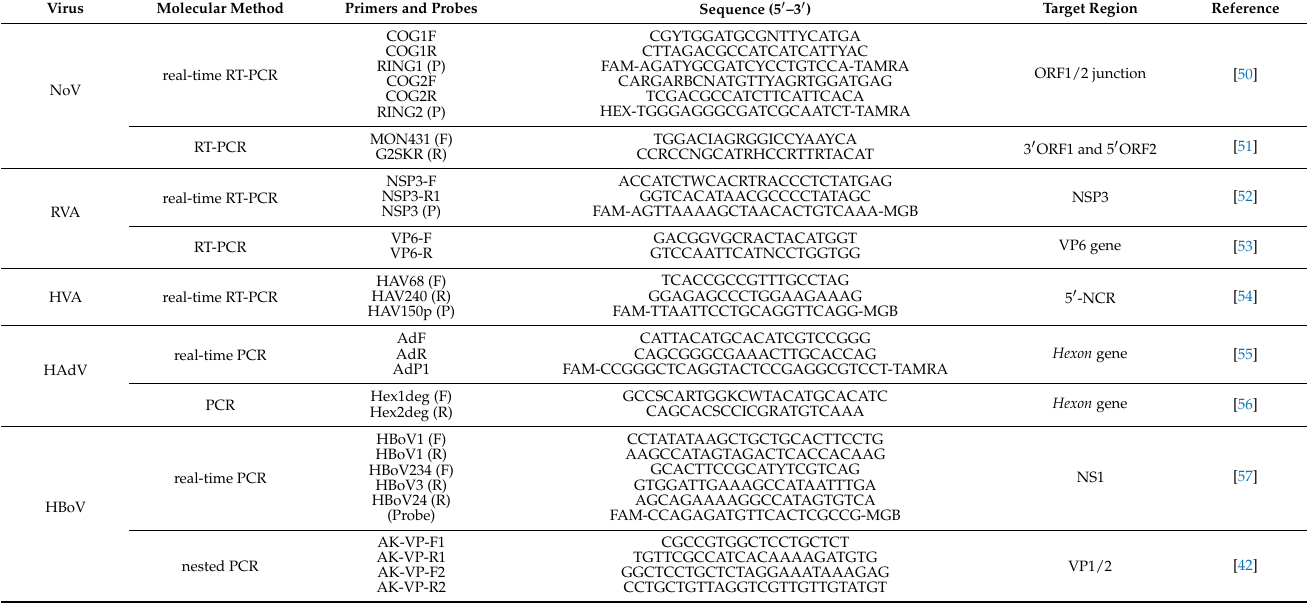
Table 1. Primers and probes used for viral detection and